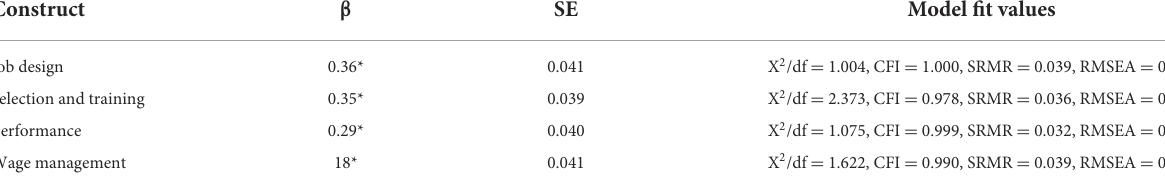
TABLE 5 GHRM sub-dimensions–work engagement path analysis values.